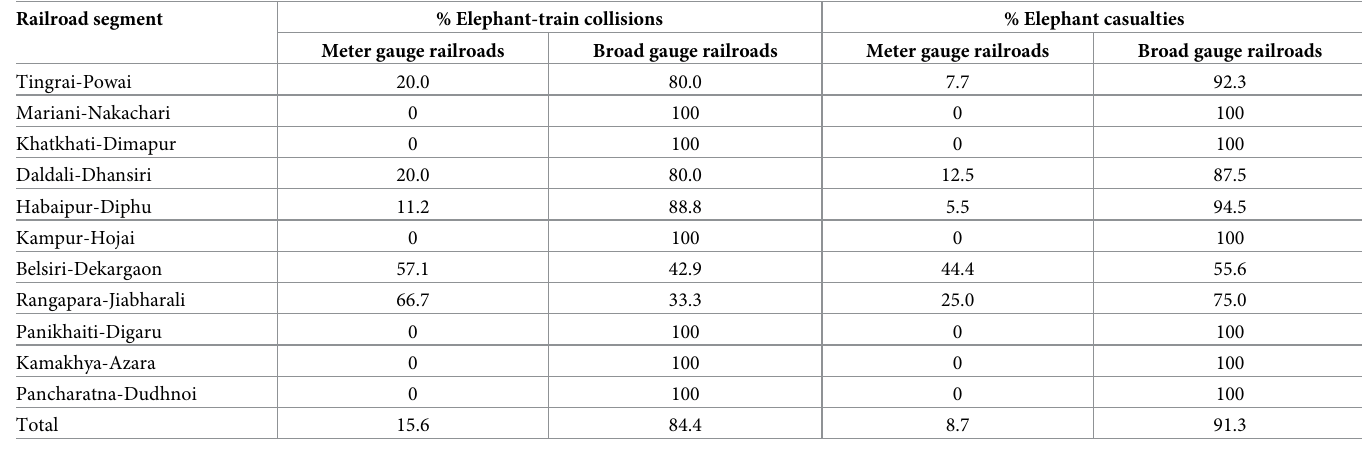
Table 4. The proportions of elephant-train collisions and casualties (1990–2018) along the meter and broad gauge railway tracks. Railroad segment % Elephant-train